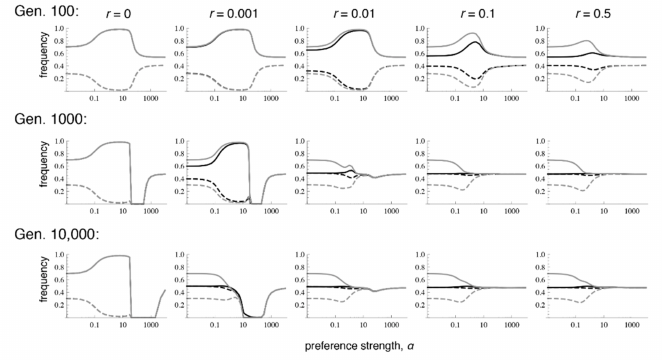
Figure 4. Preference and trait divergence at 100, 1000, and 10,000 generations after secondary contact when the trait is expressed in only in males. The parameter values and legend follow Figure 1. Convergence to equilibrium is much slower when selection on the trait occurs only in males, versus when it occurs in both sexes.